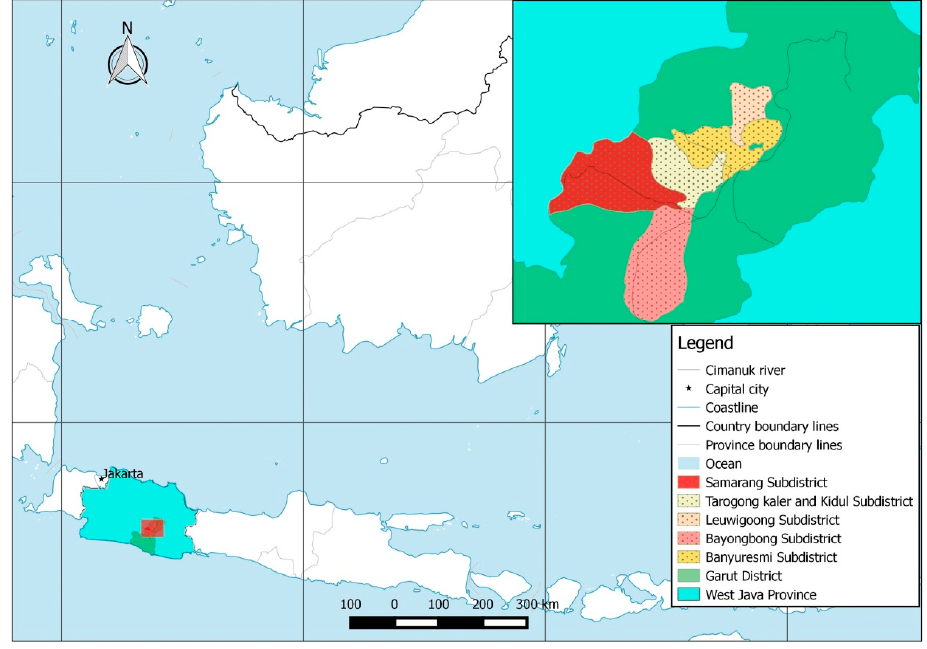
Figure 2. Location of study area.